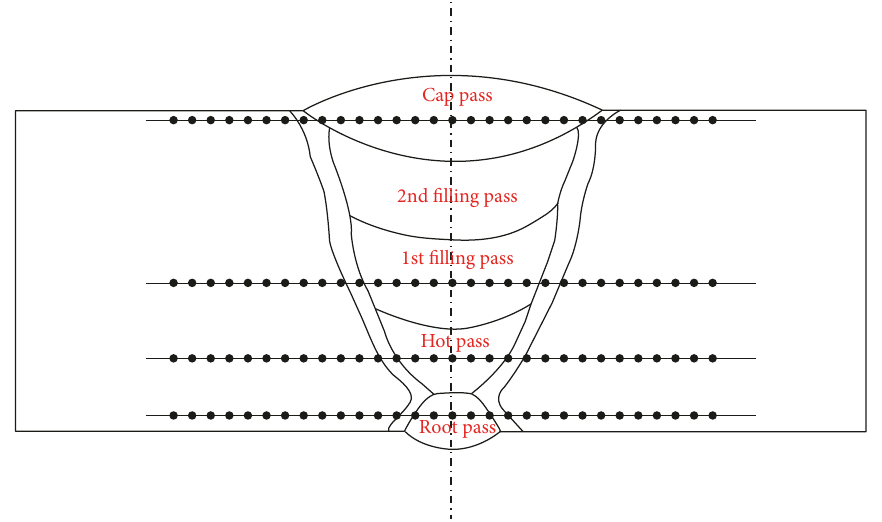
Figure 2: Schematic of tested paths for Vickers hardness.